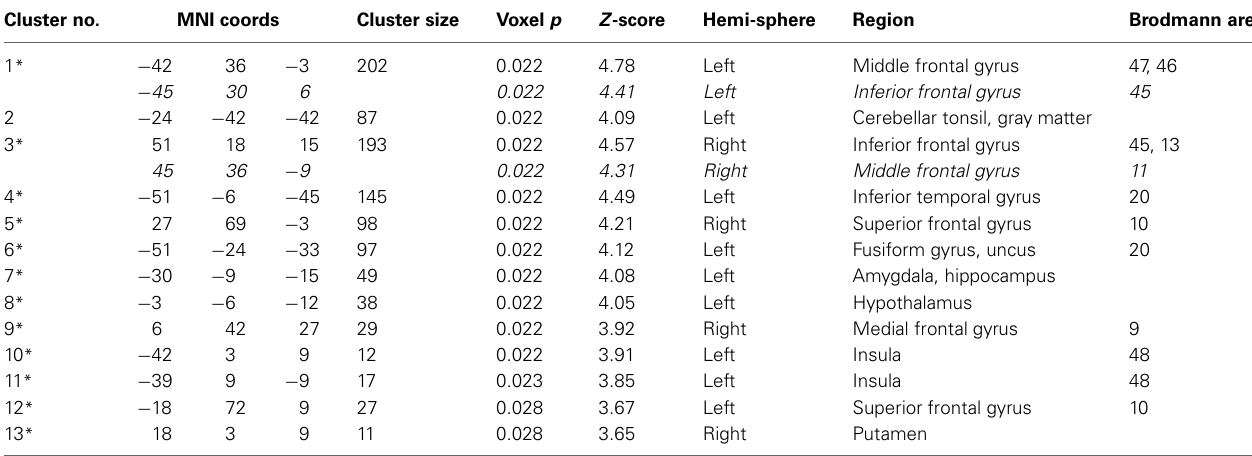
Table 3B | As in 3A but for the SZ > HC contrast in the original ALFF analysis. Cluster no.